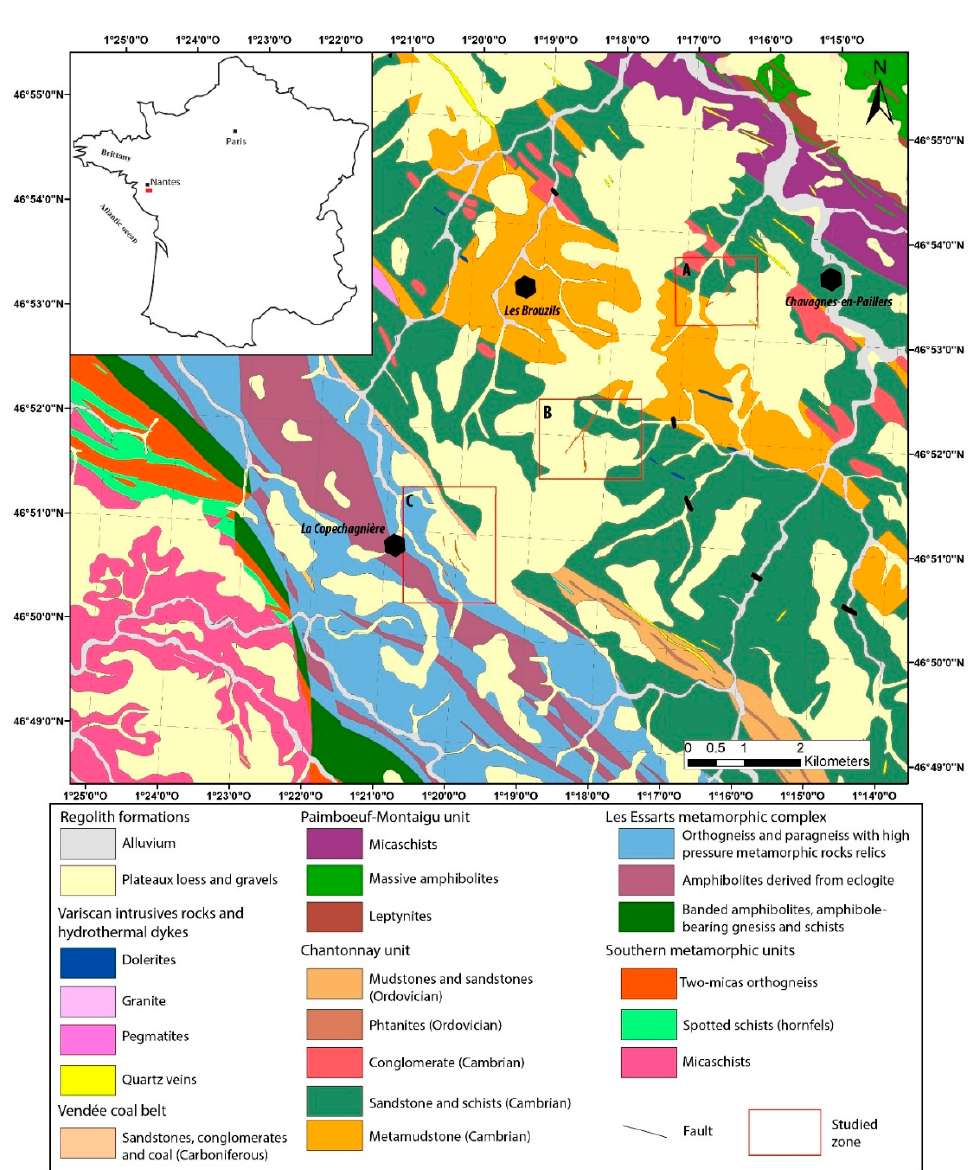
Figure 1. Geological map of the study area (modified from the geological maps at 1/50,000 scale of the Vendée district, [20]). The study areas are: A: La Télachère. B: Les Brouzils, C: La Copechagnière. Size of insert map is 1000 × 1000 km.